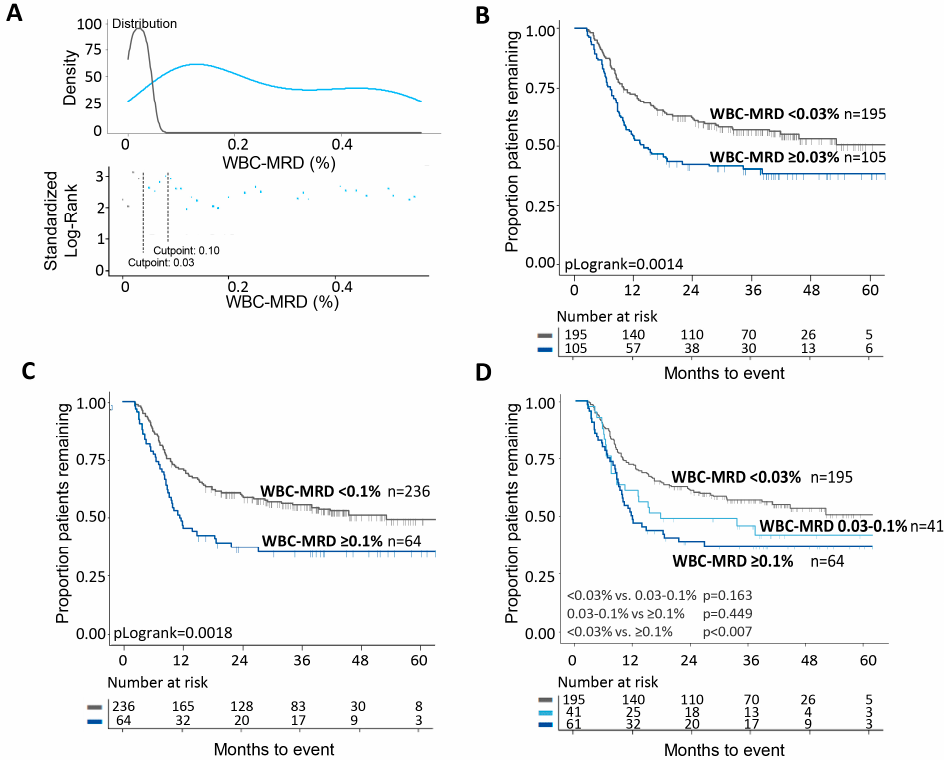
Figure 3. Prognostic impact of different WBC-MRD cut-off values. ( A ) Using MaxStat analysis, optimal cut-off values of 0.03% and 0.1% were identified (X-axis denotes % WBC-MRD). In contrast to PM-MRD, the cut-off points are not that clear, especially for a cut-off value of 0.1%. ( B ) Using the cut-off of 0.03%, two patient groups showed an EFS of 40.0% for WBC-MRD positive patients and an EFS of 55.9% for WBC-MRD negative patients. ( C ) For the 0.1% cut-off values, these groups showed an EFS of 37.5% for MRD positive patients and an EFS of 53.8% for MRD negative patients. ( D ) When both were combined, three patient groups with different EFS were shown: 55.9%, 43.9%, and 37.5%.